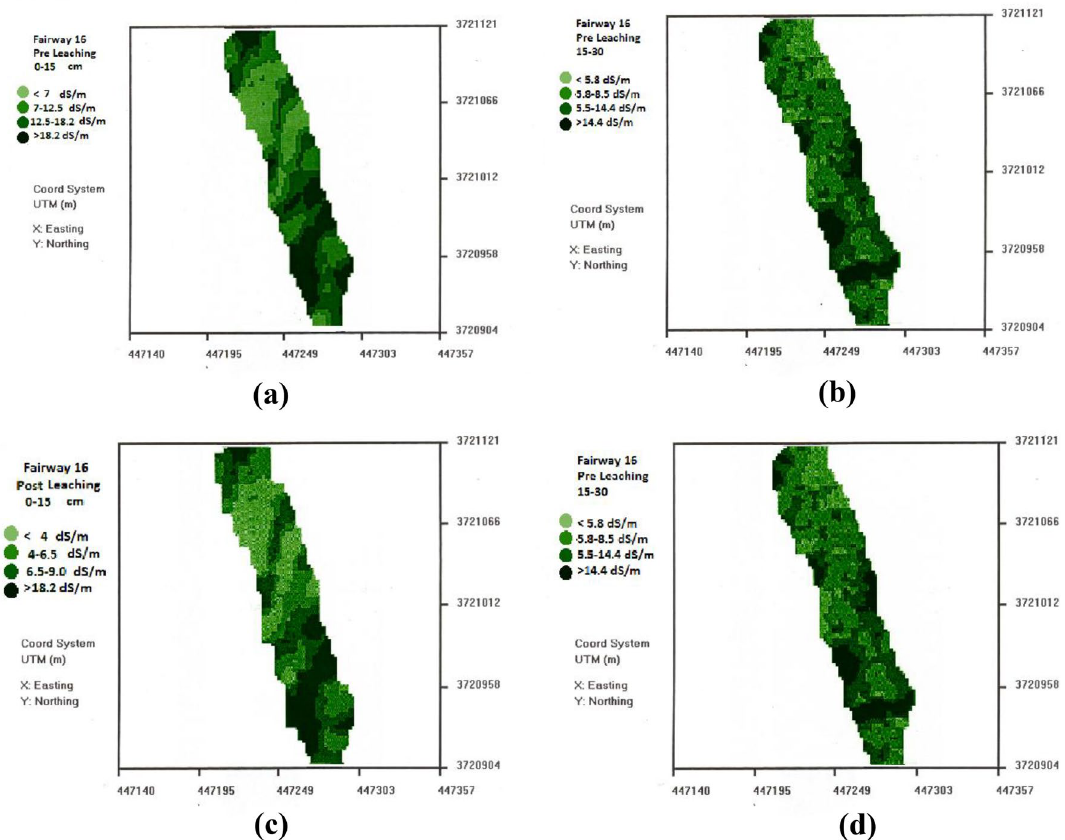
Figure 1. Pre-leaching ( a ) 0–15 cm, ( b ) 15–30 cm and post leaching ( c ) 0–15 cm, ( d ) 15–30 cm salinity maps (ECe) for fairway 16 created using